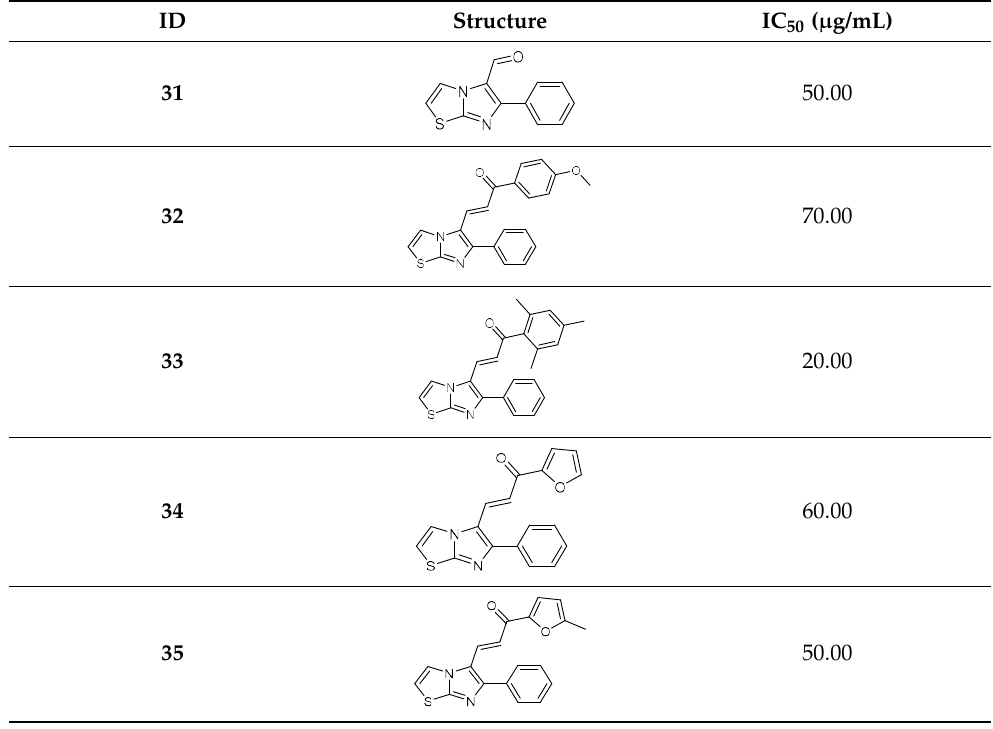
Table 5. IC 50 values of the tested imidazothiazole derivatives against F.o.a.